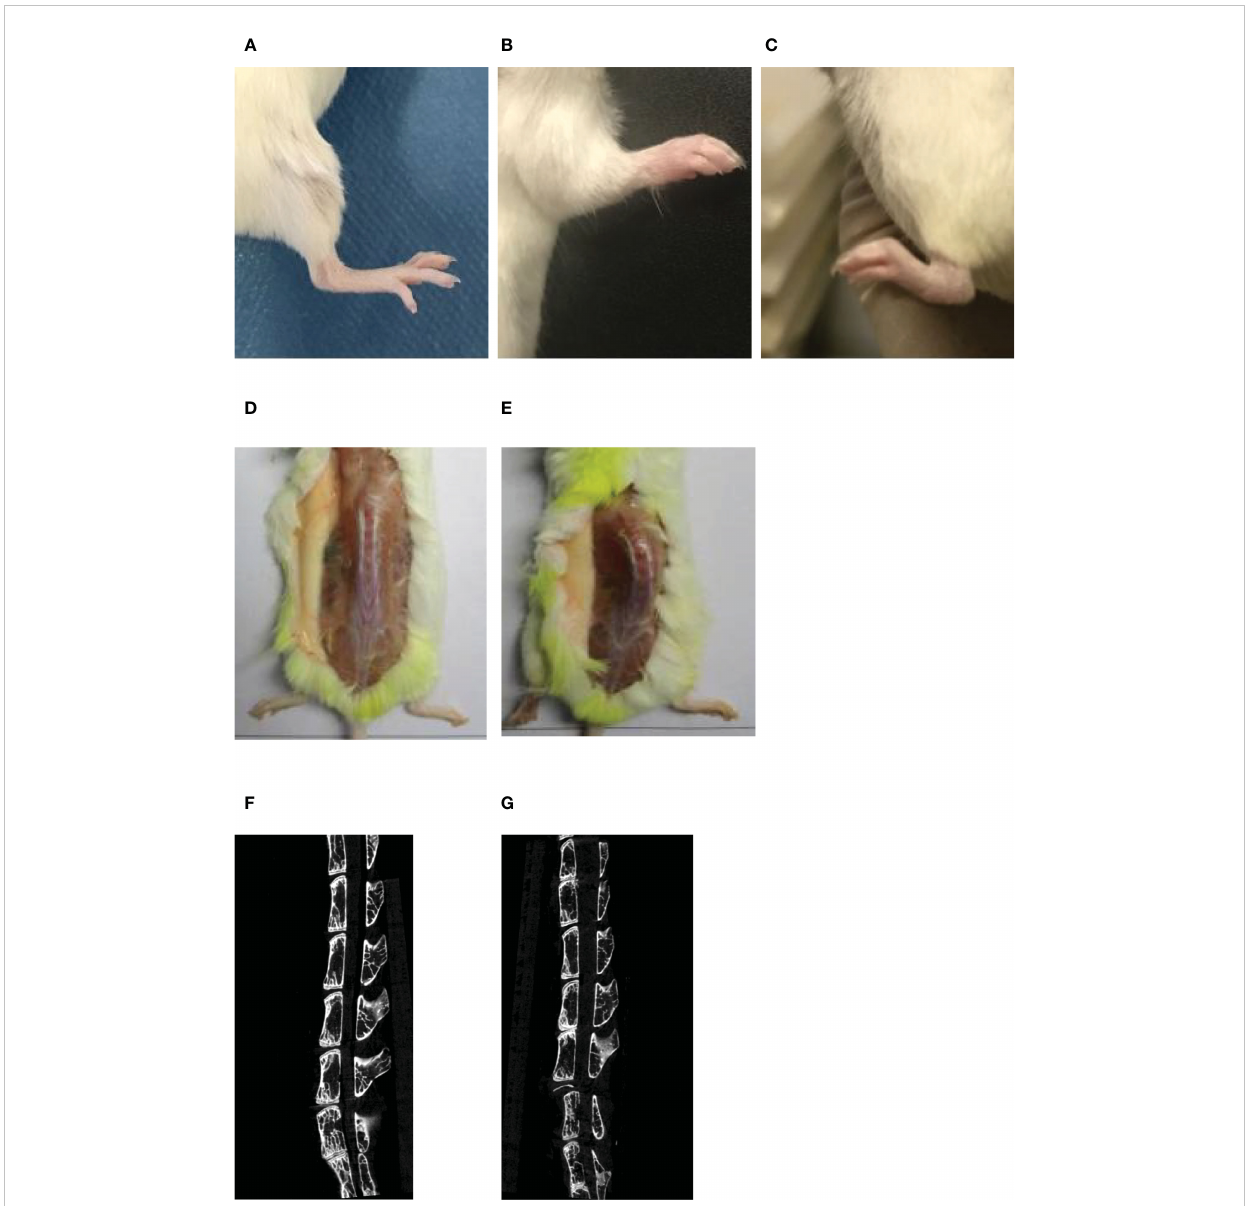
FIGURE 2 The symptoms of limbs and spines in normal/PGISp mice by taking pictures and CT scanning 13 weeks later, (A) : picture of normal hind limbs; (B) : picture of PGISp mice forelimb; (C) : picture of PGISp mice hind limbs; (D, E) : pictures of normal/PGISp mice spines, (F, G) : CT pictures of normal/PGISp mice